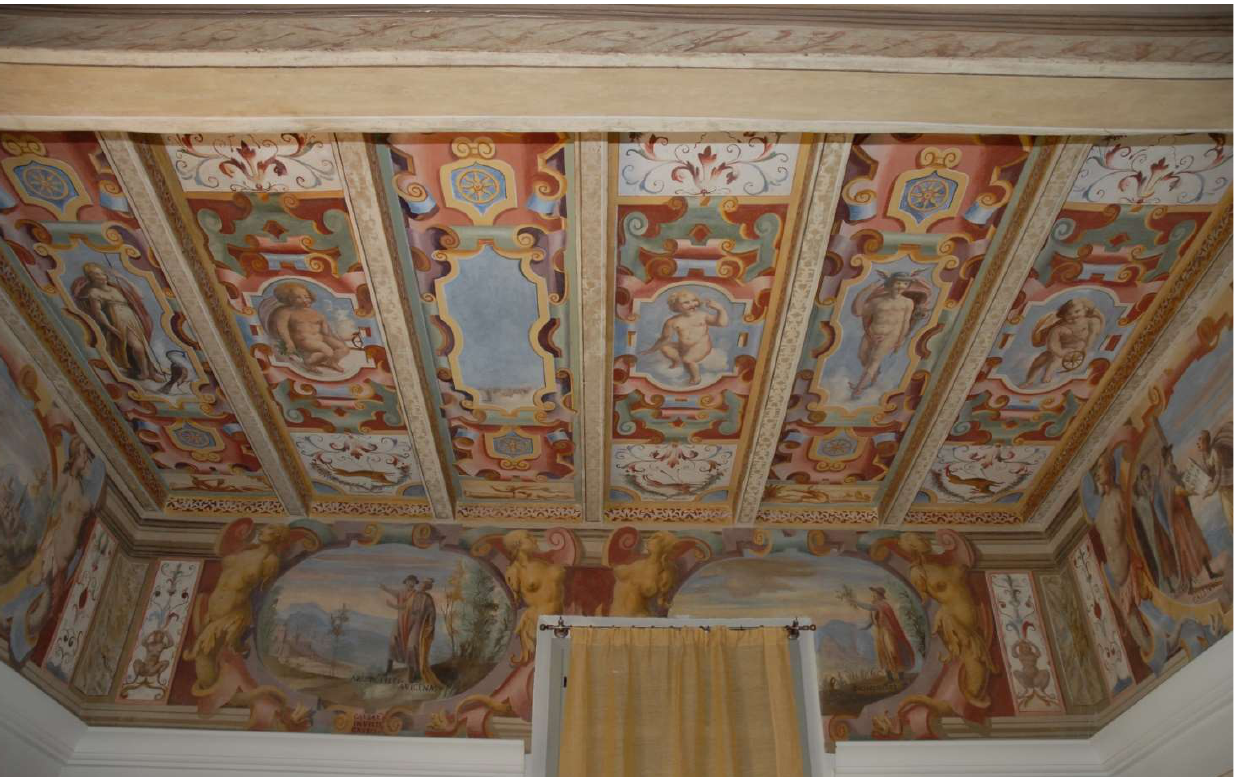
Figure 2. General view of the decoration of the ceiling of Rota’s annex.